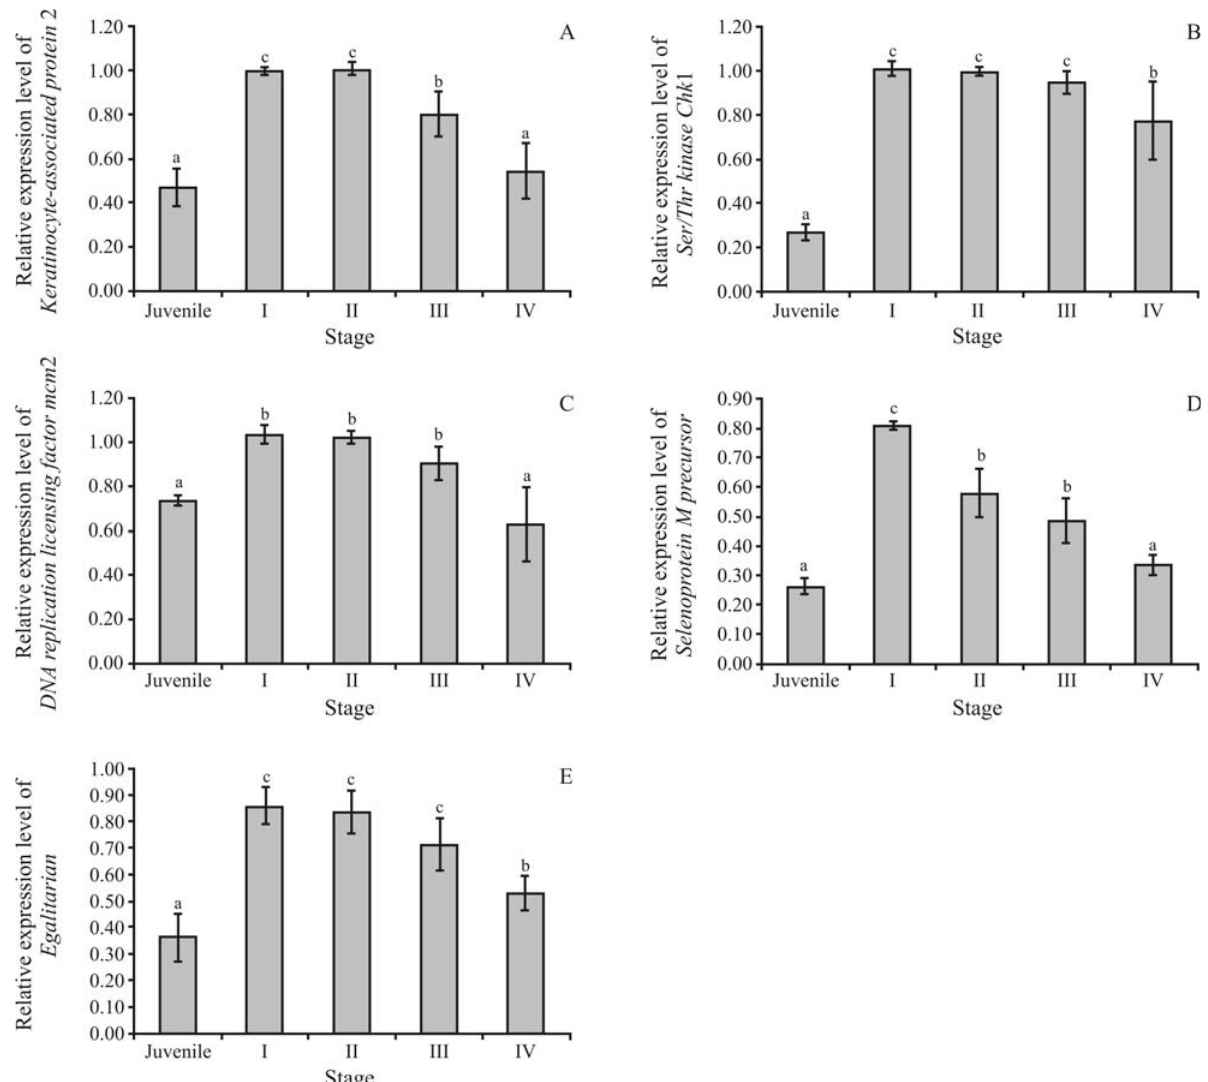
Figure 3 - Histograms showing relative expression levels of keratinocyte-associated protein 2 (A), Ser/Thr Chk1 (B), DNA replication licensing factor mcm2 (C), selenoprotein M precursor ( PmSePM ; D) and egalitarian (E) in different ovarian developmental stages of P. monodon . For expression analy- sis, ovaries from 5 groups of shrimp (juveniles and stages I, II, III and IV broodstock, N = 4 for each group) were assays. The same letters indicate that the relative expression levels were not significantly different (p >